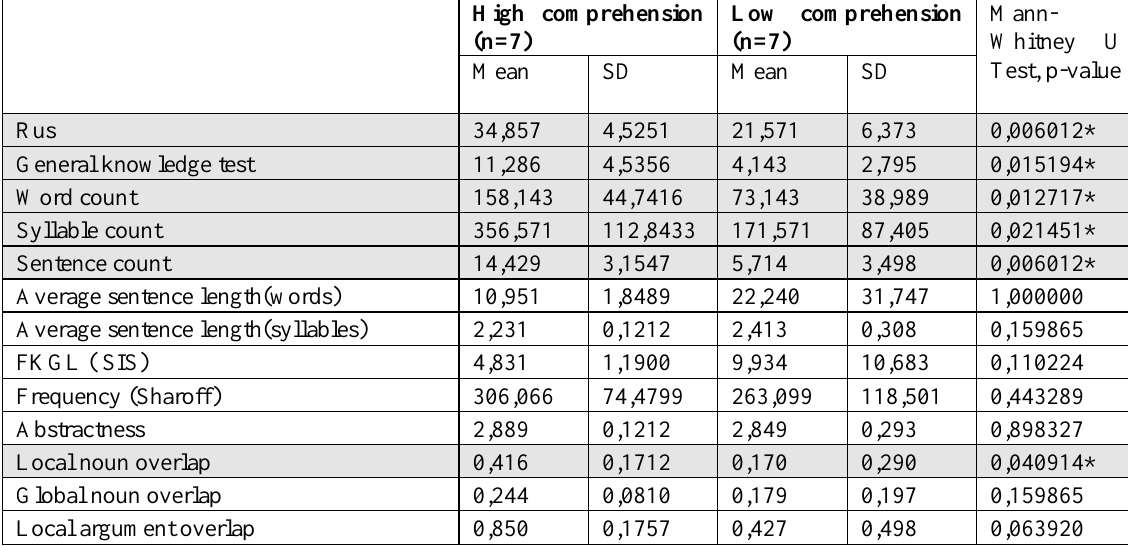
High comprehension (n=7)